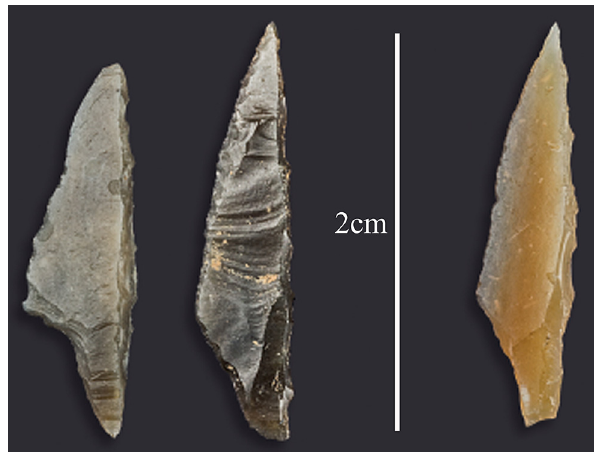
Figure 5: Bexhill points.